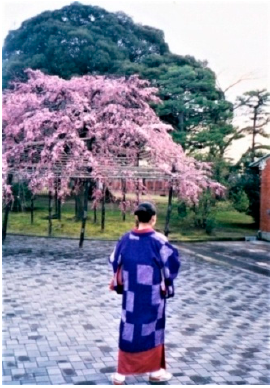
Figure 3. Spring in Japan, photo by L.